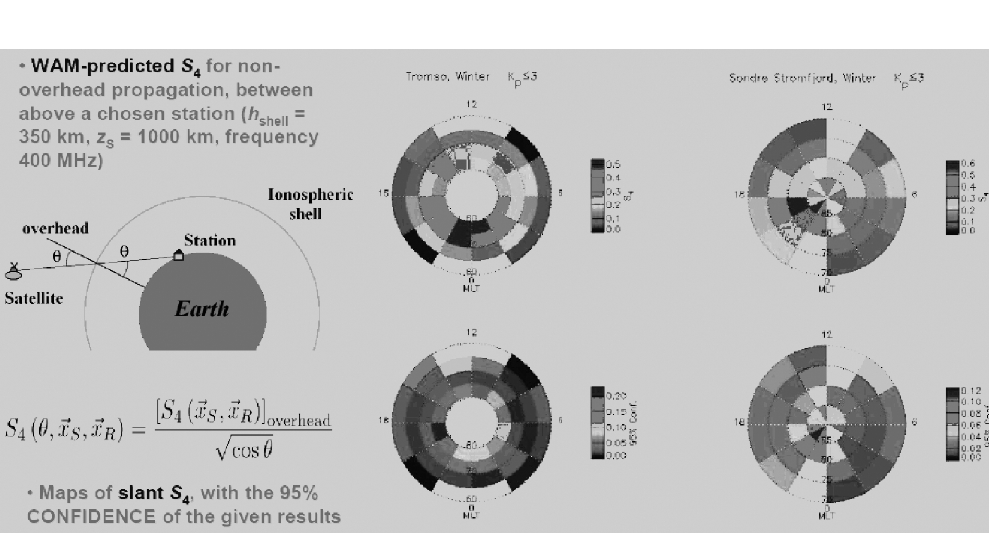
Fig. 10. An example of the prediction possible via the WAM model, giving the amplitude scintillation index within the field of view of an assigned station for certain helio-geophysical